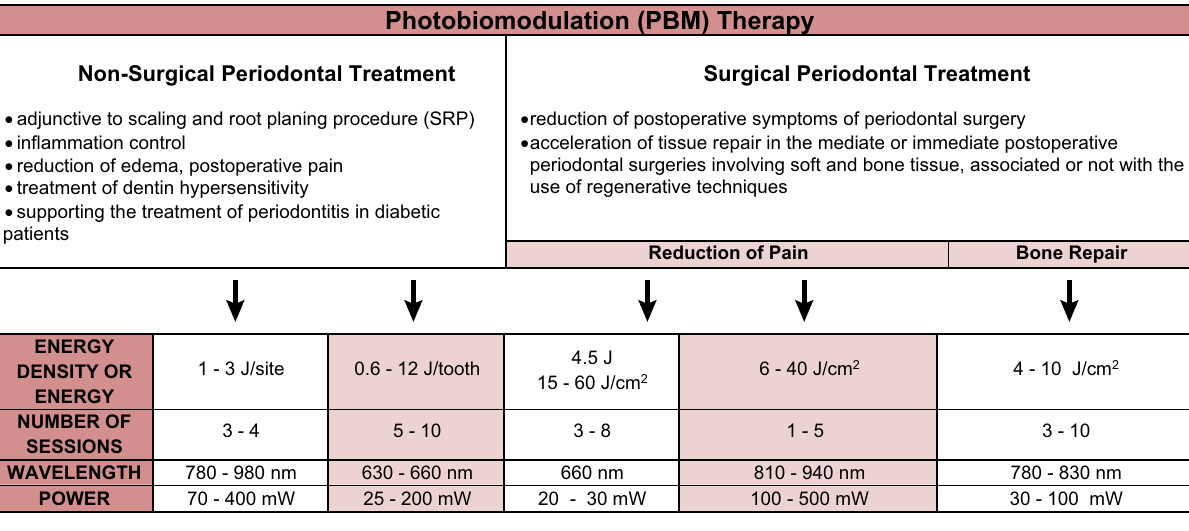
Figure 2. Indications and irradiation parameters of the low-level lasers (PBM) described in the periodontal